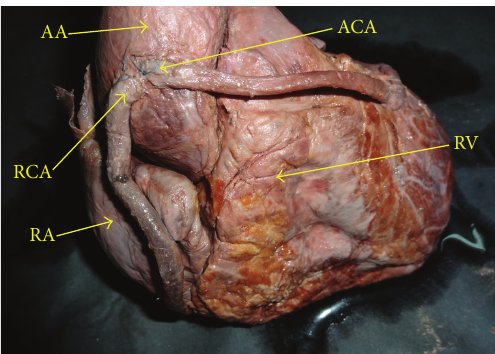
Figure 1: Showing high origin of coronary artery. AO: abdominal aorta, RCA: right coronary artery, ACA: accessory coronary artery, RA: right atrium, RV: right ventricle.